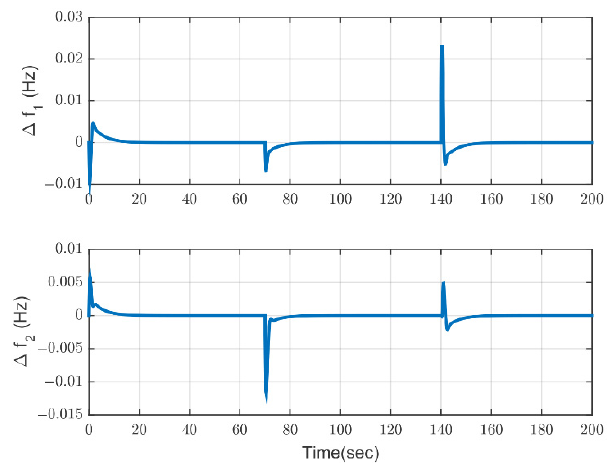
Figure 10. Frequency deviation of the proposed LFC controller during a random step load disturb- ance.